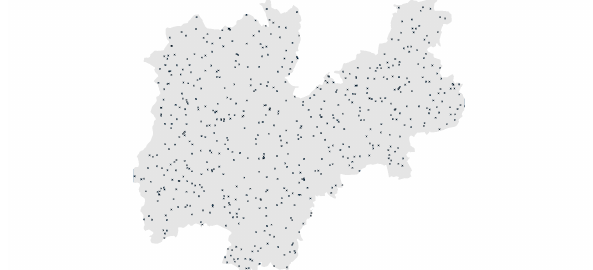
Figure 5. Sampling points distribution.